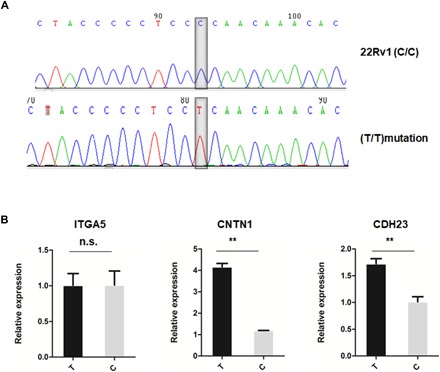
Risk allele of SNP rs55958994 in 22Rv1 cells affected the expression levels of CNTN1 and CDH23.(A) Site-directed mutation by CRSPR-Cas9 and sequencing of SNP rs55958994 nonrisk (C) and risk (T) alleles in 22Rv1cells. (B) CDH23 and CNTN1 expressions are increased in cells with risk (T) allele of rs55958994 compared with WT 22Rv1 cells with (C) allele of rs55958994, while no significant alteration of ITGA5 expression was detected in cells with risk (T) allele of rs55958994. Data represent means ± SEM of three independent experiments. **P < 0.01. n.s., not significant.